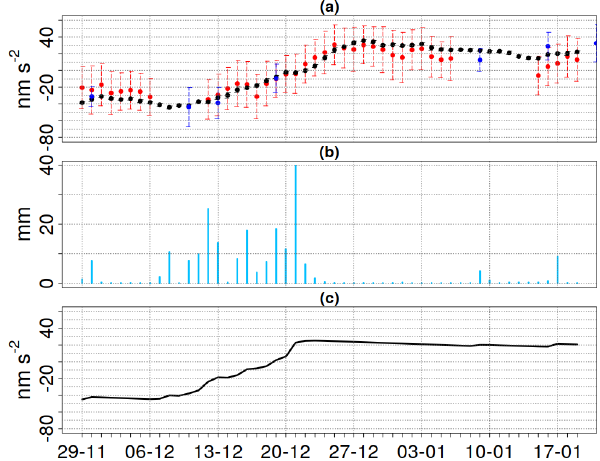
Figure 5. (a) AQG-B01 (red), FG5-228 (blue), and iGrav-002 (black) daily gravity residuals at the Larzac observatory in nms − 2 . Residuals of g refer to the mean of the shown measurements. The error bars refer to the standard deviation of 24h of measurement.